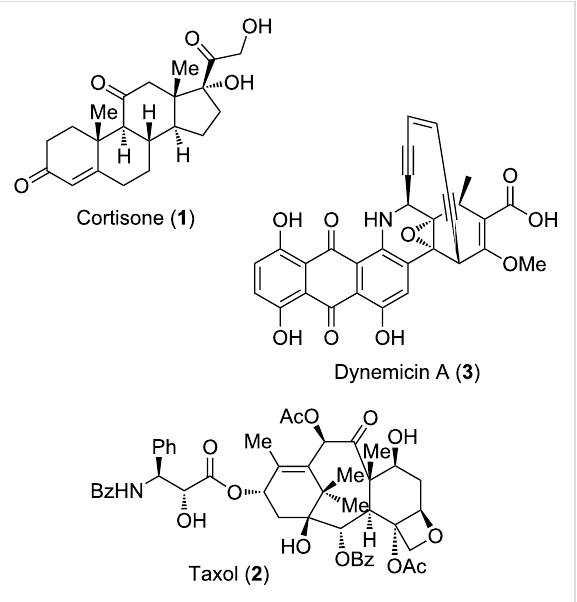
Figure 1: An assortment of natural products synthesized by Diels–Alder reactions.